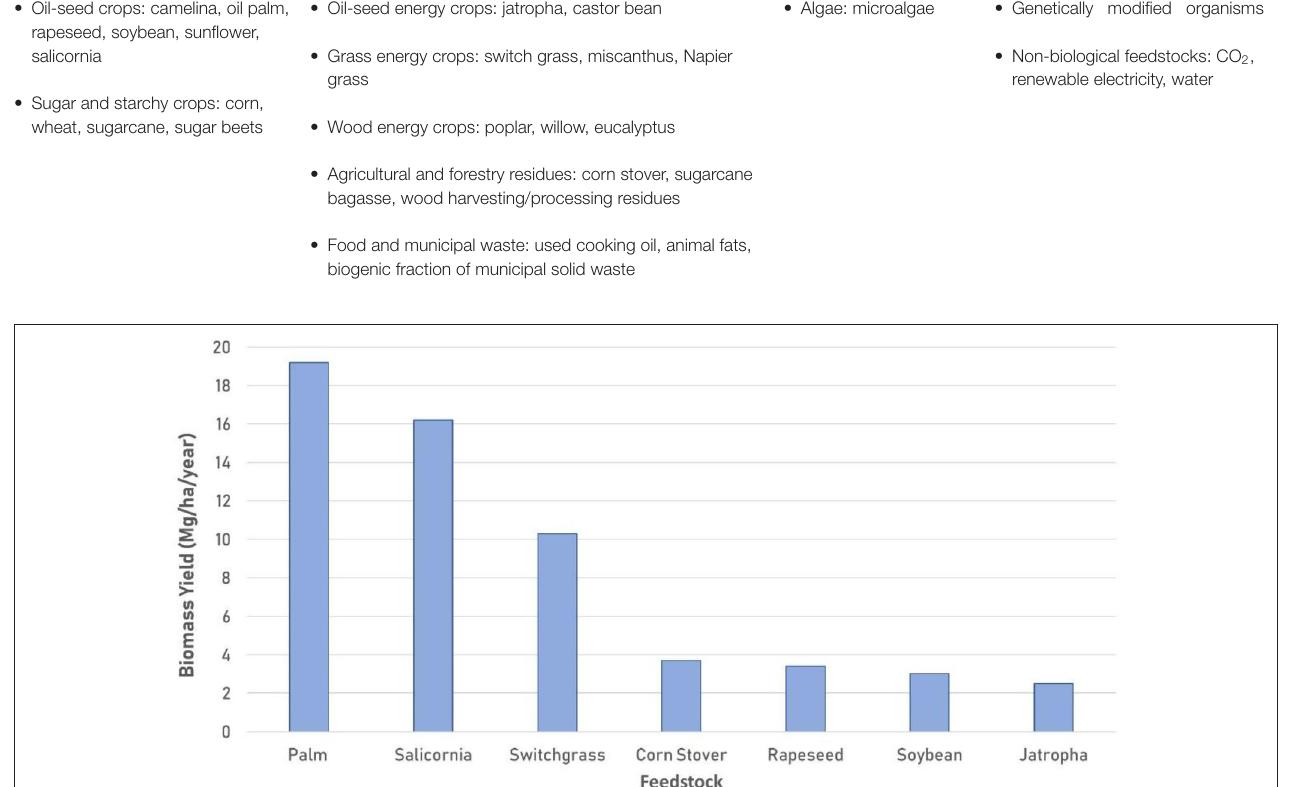
FIGURE 2 | Typical potential yields of some 1-G and 2-G feedstocks for BAF production (Plotted using data from Stratton et al.,